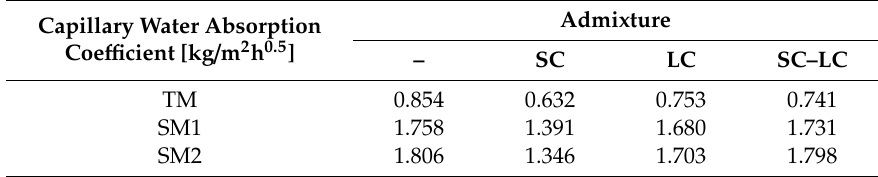
Table 5. Capillary water absorption coefficient (AC) of mortars with different admixtures.